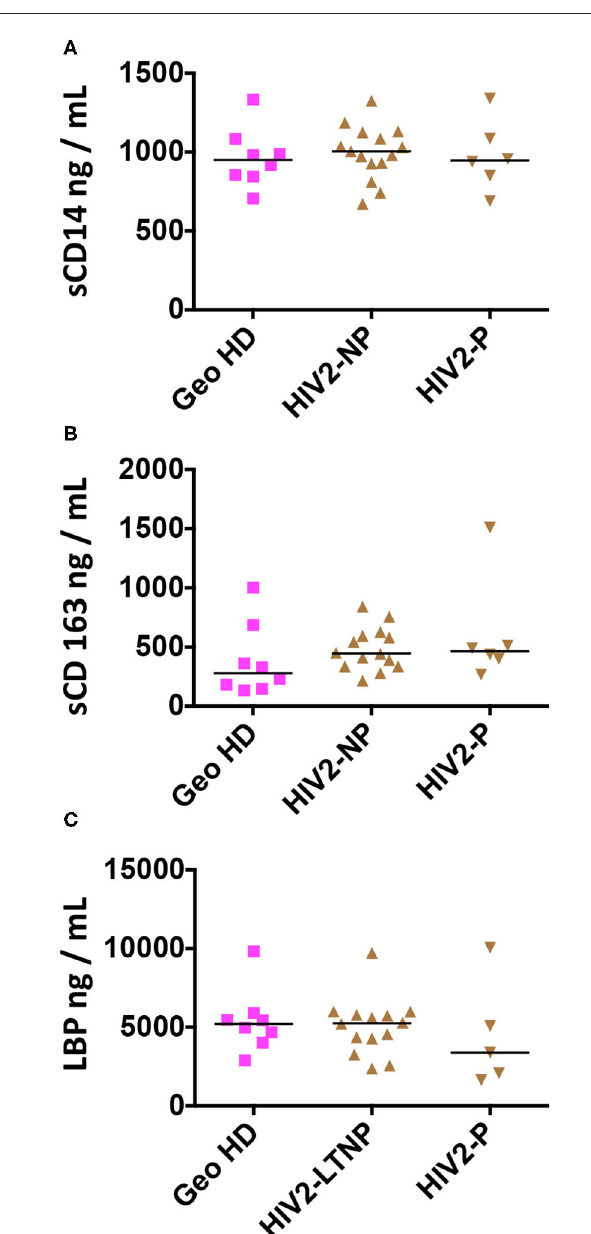
FIGURE 4 | Plasma concentrations of sCD14, sCD163 and LBP in HIV-2-infected participants and uninfected controls (GeoHD), all of West African origin. Plasma concentrations of (A) sCD14, (B) sCD163, and (C) LBP. Horizontal bars represent median values. Kruskall-Wallis test and descriptive statistics can be found in Table 4 .